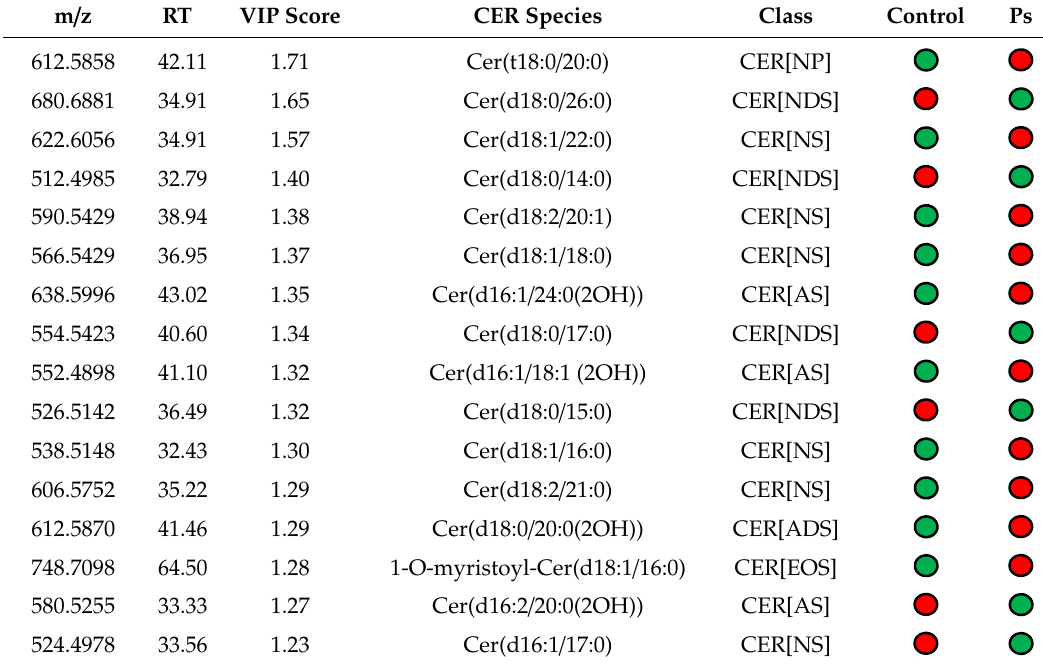
Table 2. Changes in 16 ceramides with higher discriminating power identified in keratinocytes with variable importance in projection (VIP) score greater than one; the colored circles indicate the relative level of the corresponding metabolite in each group under study.